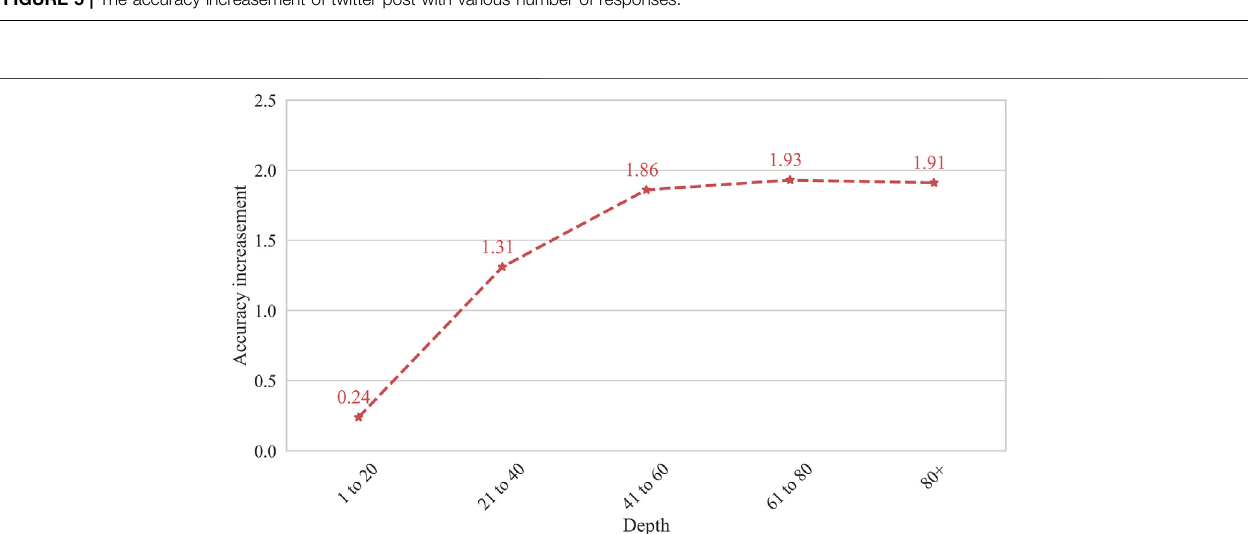
FIGURE 6 | The accuracy increasement of microblog post with various number of responses.